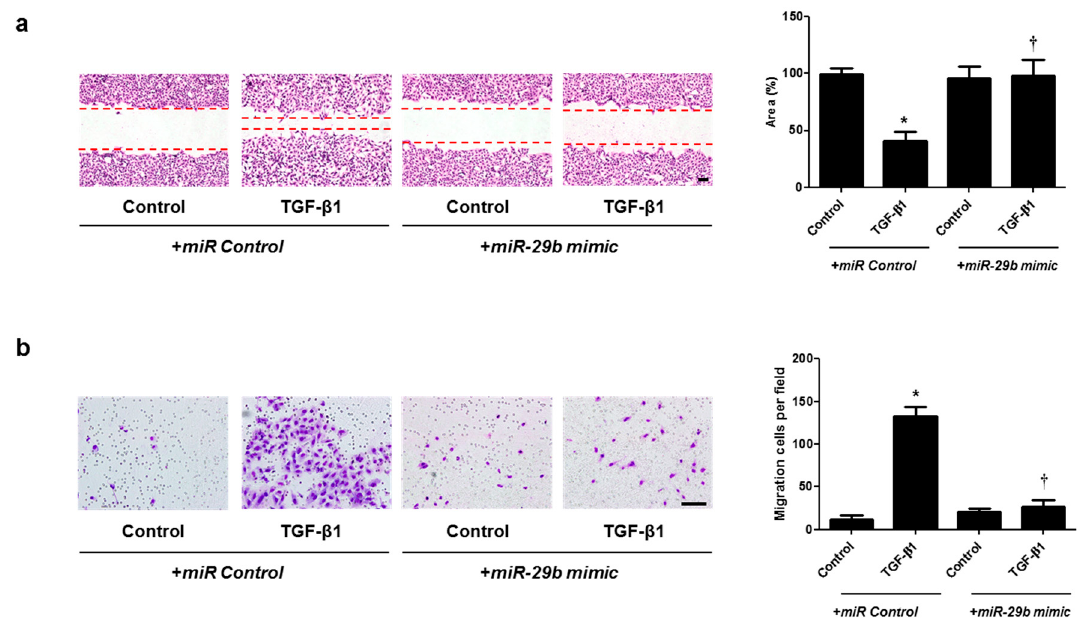
Figure 5. Overexpression of miR-29b contributed to A549 cell migration. A549 cells were seeded and transfected with miR control or miR-29b mimic before treatment with TGF- β 1 for 72 h. ( a ) A wound scratch migration assay was performed to investigate the migration of A549 cells. Microscopic observation was performed 72 h after scratching the surface of a confluent layer of cells. ( b ) Inhibitory effects of the miR-29b mimic are also shown using a transwell migration assay. Scale bar = 100 μ m. Data are expressed as the mean ± SEM of three independent experiments. * p < 0.05, vs. control + miR Control ; † p < 0.05, vs. TGF- β 1 + miR Control .